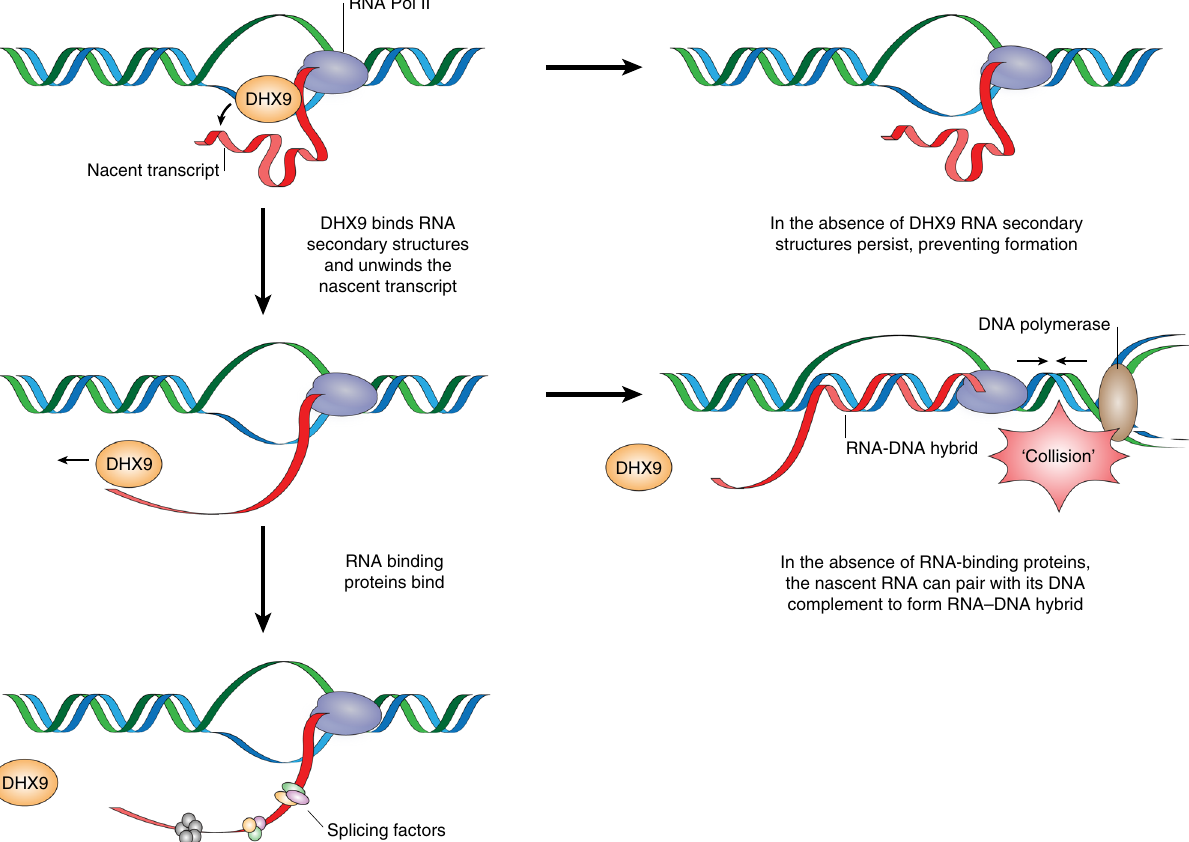
Fig. 10 DHX9 promotes the generation of R-loops. Model showing how DHX9 promotes the formation of R-loops by unwinding the nascent RNA to generate the free RNA end, which is required for the invasion of duplex DNA and generation of DNA – RNA hybrid. RNA-binding proteins prevent R-loop formation by binding to the nascent RNA inhibiting its ability to pair with its complementary DNA template. In the absence of RNA-binding proteins, the free RNA end that is generated by DHX9 is available for R-loop formation. This may lead to RNA Pol II becoming trapped on chromatin where it can pose a barrier to DNA replication and increases the likelihood of transcription – replication con fl icts. In the absence of DHX9, the formation of secondary structures in the nascent RNA prevent it from invading the DNA duplex to form (BSA)/PBS for 30 min. Cells were incubated with primary antibody (as indicated above), followed by the addition of Alexa Fluor-488 or -594 conjugated secondary antibodies (1:1000). To visualize nuclei, cells were also stained with 0.5 μ g/ml DAPI (Molecular Probes). Slides were mounted using Prolong gold anti-fade reagent (Invitrogen) and images were acquired using a Deltavision DV4 wide- fi eld deconvolution microscope with a ×100 objective. To detect DNA – RNA hybrid, cells were stained with S9.6 antibody as described 27 . Cells were co-stained with antibody against nucleolin, which was used to mask nucleolar regions for quanti fi cation of S9.6 staining. The nuclear S9.6 signal was determined subtracting the S9.6 staining intensity of the region co- stained with nucleolin from the total nuclear S9.6 stain. Images were analyzed using a DeltaVision microscope and quanti fi ed using image J software. Cell growth assay . U2OS cells were transfected with siRNA for 48 h and 50,000 cells were seeded into a six-well plate (time 0). At the indicated times, cells were recovered from the monolayer using trypsin and counted using the Casey Cell Counter. Growth curves were plotted using data from three independent biological replicates.